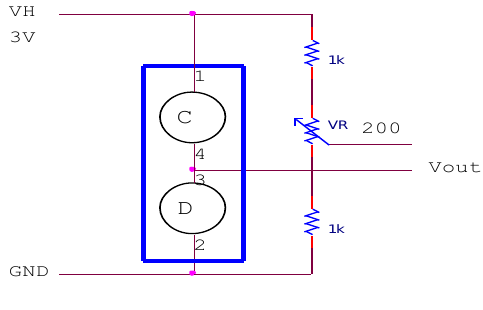
Figure 4. Measuring circuit for TGS6812